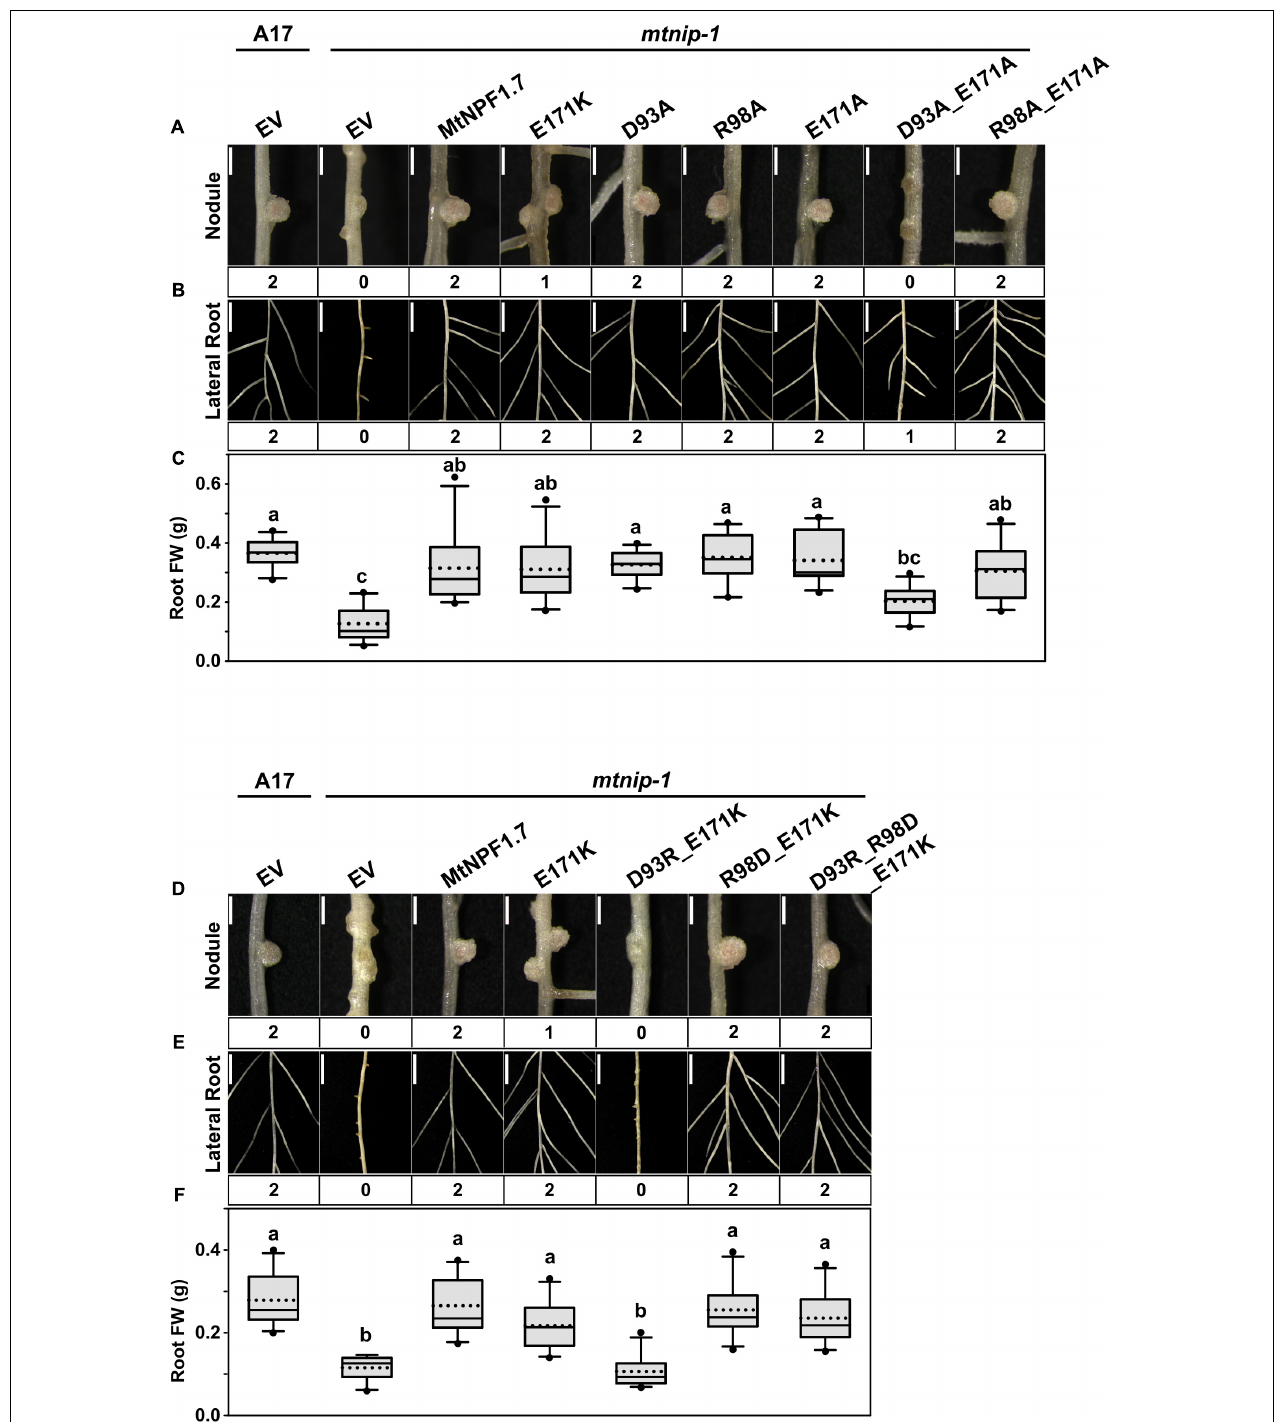
FIGURE 5 | Results of in planta complementation for Motif A mutants. Images showing (A) the nodules, (B) the lateral roots, and (C) plots of root fresh weight from ten independent transgenic plants of (from left to right) A17 plant roots transformed with pMU06 empty vector (EV), and mtnip-1 plant roots transformed with EV, MtNPF1.7_wt (pYCY400), _E171K (pYCY402), _D93A (pYCY412), _R98A (pYCY413), _E171A (pYCY414), _D93A-E171A (pYCY415), and _R98A-E171A (pYCY416). Images showing (D) the nodules, (E) the lateral roots, (F) plots of root fresh weight from ten independent transgenic plants of (from left to right) A17 plant roots transformed with EV, and mtnip-1 plant roots transformed with EV, MtNPF1.7_wt (pYCY400), _E171K (pYCY402), _D93R-E171K (pYCY417), _R98D-E171K (pYCY418), and _D93R-R98D-E171K (pYCY419). Nodules and lateral roots were evaluated by complementation levels shown below each image as described in Figure 2 . (A,D) Bars = 1 mm. (B,E) Bars = 5 mm. (C,F) See Figure 2D for statistical details.